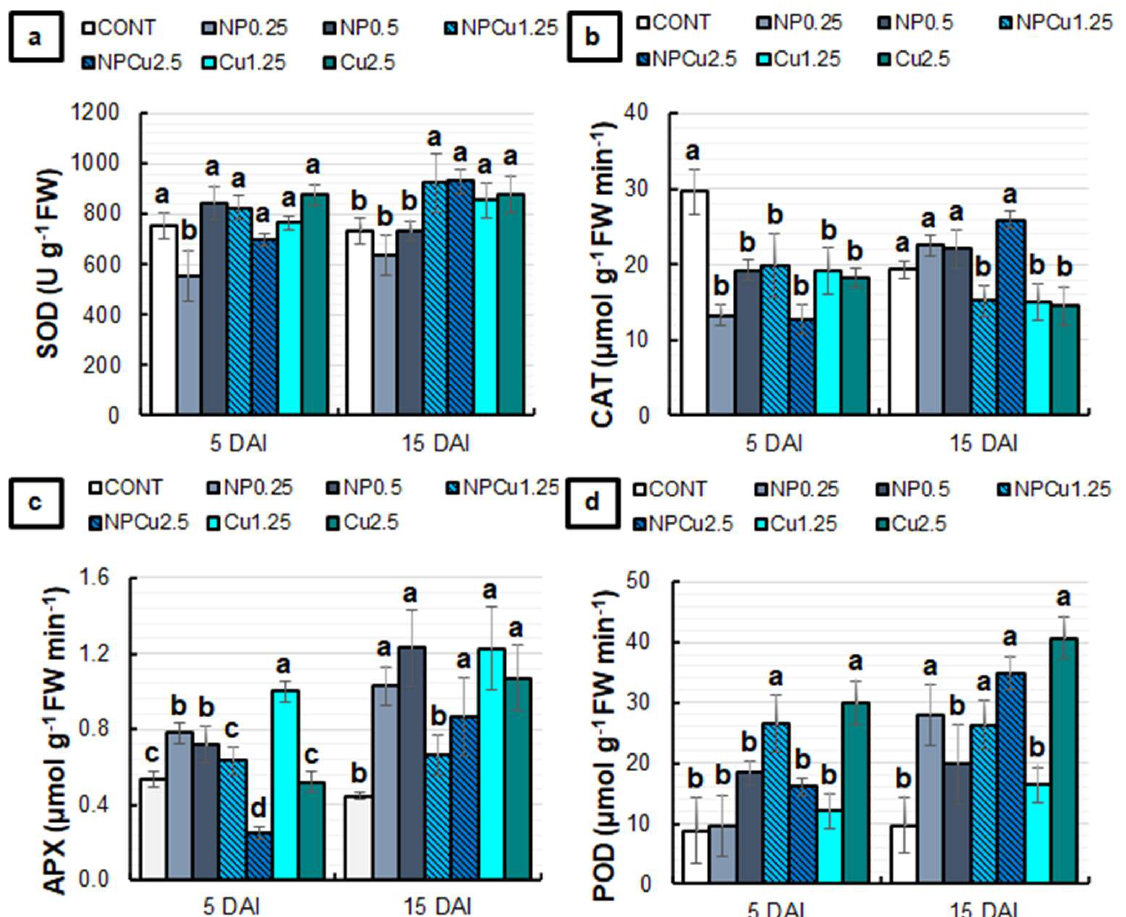
Figure 7. The activity of Superoxide dismutase (SOD) ( a ), Catalase (CAT) ( b ), Ascorbate peroxidase (APX) ( c ), and Peroxidase (POD) ( d ) of leaf discs of Coffea arabica cv. IPR 100 at 5 and 15 days after infection (DAI) with H. vastatrix . Before infection, the discs were treated with distilled water as a control (CONT), chitosan nanoparticles without Cu 2+ ions (NP), chitosan nanoparticles containing Cu 2+ ions (NPCu), and free Cu 2+ ions (Cu). The formulations were diluted in distilled water, obtaining the corresponding concentrations of chitosan (CS) in NP and NPCu treatments (0.25; 0.5 g L − 1 ) and of Cu 2+ ions (1.25; 2.5 mmol L − 1 ) in NPCu and Cu treatments. Results are expressed as mean ( n = 4) ± standard error. Equal letters in the columns indicate that there was no significant difference in the Scott–Knott test ( p < 0.05) at the same time point.